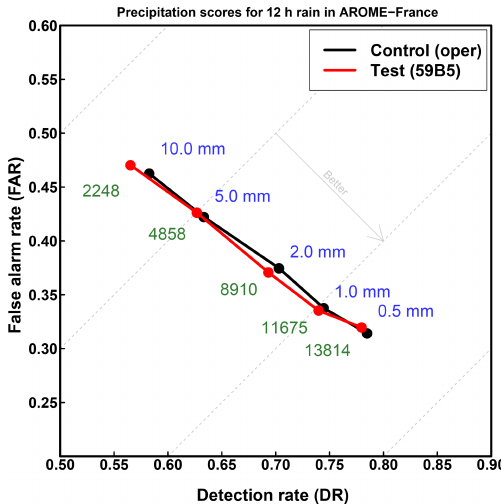
Figure 6. Detection rate (DR) and false alarm rate (FAR) plot for each of 10, 5, 2, 1 and 0.5mm precipitation thresholds computed on 12h precipitation forecast issued at 12:00UTC (30 cases). Refer- ence is given by the rain gauge measurements. Red dots are for the denial experiment, black dots represent the operational AROME- Fr suite. Close to each plot is given the threshold (in blue) and the number of data points (in